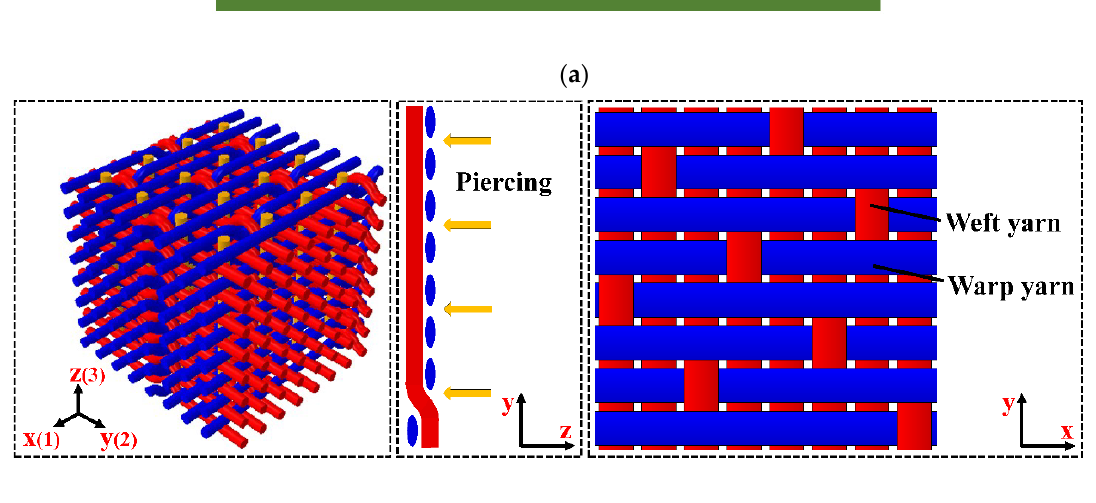
Figure 4. Preparation of the coated C/C composite plates. Figure 5. Lap plate, fasteners, and their lap mode.